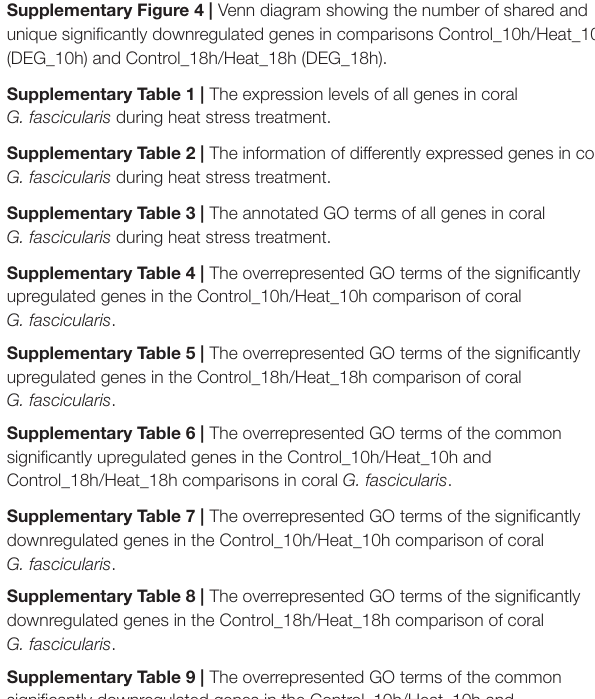
Supplementary Figure 3 | Venn diagram showing the number of shared and unique significantly upregulated genes in comparisons Control_10h/Heat_10h Supplementary Figure 4 | Venn diagram showing the number of shared and unique significantly downregulated genes in comparisons Control_10h/Heat_10h (DEG_10h) and Control_18h/Heat_18h (DEG_18h). Supplementary Table 1 | The expression levels of all genes in coral G. fascicularis during heat stress treatment. Supplementary Table 2 | The information of differently expressed genes in coral G. fascicularis during heat stress treatment. Supplementary Table 3 | The annotated GO terms of all genes in coral G. fascicularis during heat stress treatment. Supplementary Table 4 | The overrepresented GO terms of the significantly upregulated genes in the Control_10h/Heat_10h comparison of coral G. fascicularis